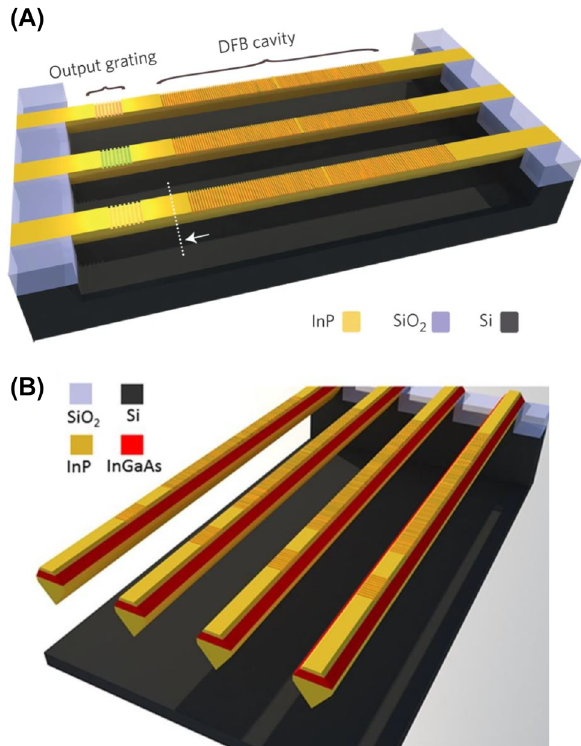
Figure 6: Unidirectional, heterogeneous integrated widely tunable laser: (A) schematic, and (B) output spectra and SMSR as functions of wavelength.